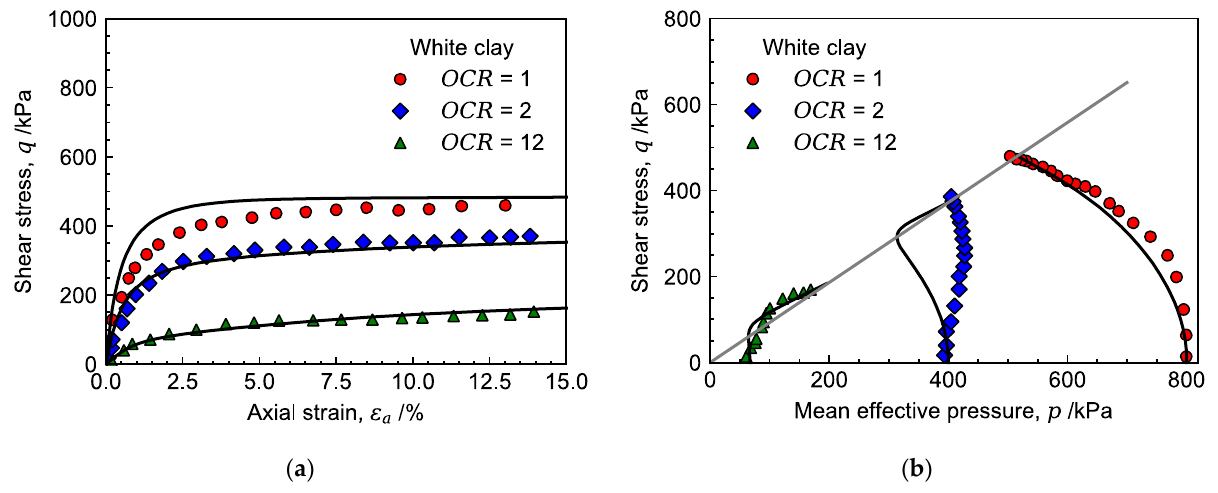
Figure 9. Measured and predicted undrained triaxial test results of white clay: ( a ) the shear stress– axial strain relation; ( b ) the stress path.